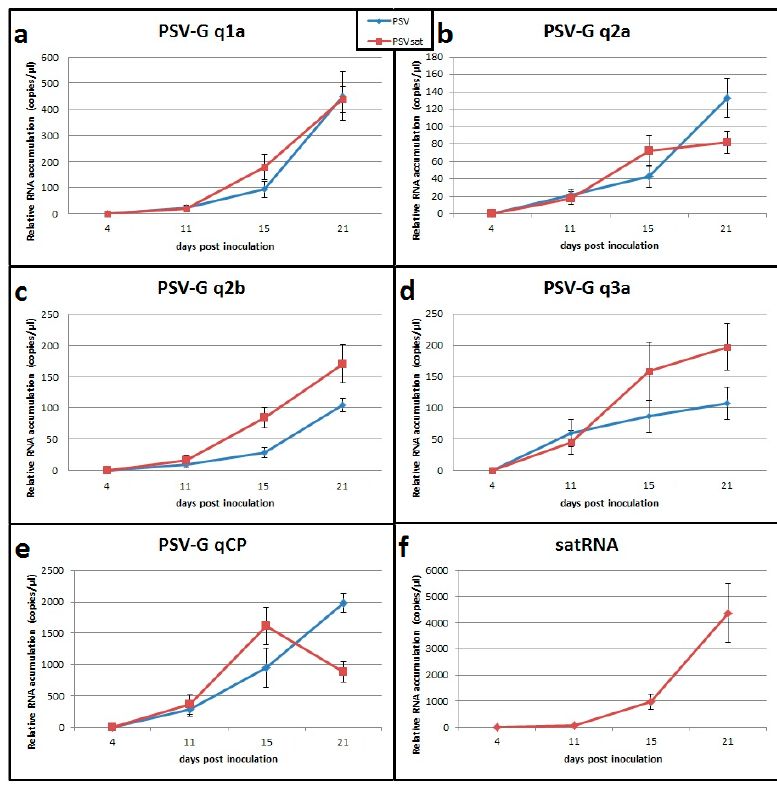
Figure 2. Time course analysis of PSV-G RNAs and satellite RNA (satRNA) accumulation levels in N. benthamiana plants. The plants were infected with PSV-G (blue) or co-infected with PSV-G + satRNA (red). ( a ) RNA encoding 1a protein; ( b ) 2a protein; ( c ) 2b protein (RNA silencing suppressor); ( d ) 3a protein (movement protein); ( e ) coat protein (CP); and ( f ) satRNA.